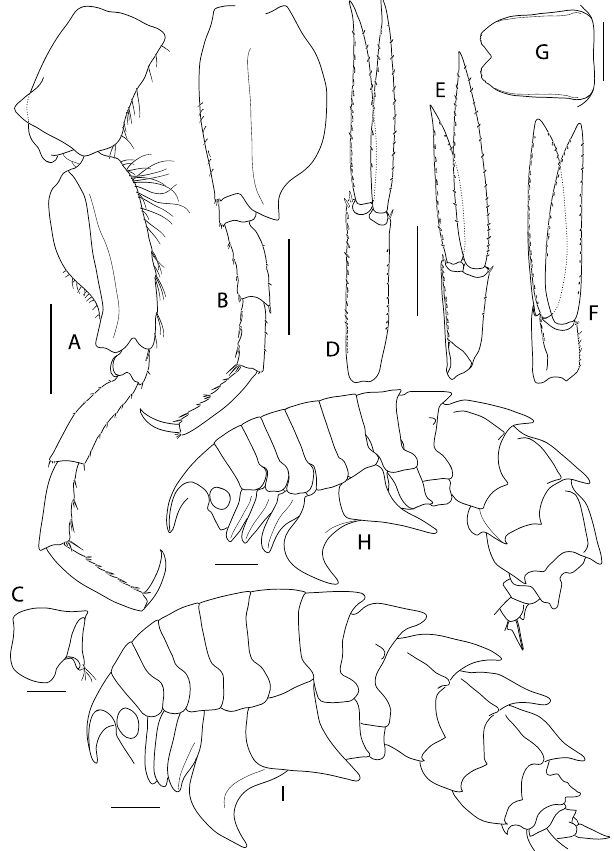
Head (Fig. 8C) about as high as long; ventral lobus slightly rounded, anterior corner rectangular. Rostrum weakly curved, ventral margin almost straight, about as long as 1 st peduncular article of antenna 1. Eyes large and rounded, bulging. Antenna 1 (Fig. 9A) peduncular article 1 about 1.4 as long as articles 2–3 combined (length ratio 1: 0.5: 0.3); accessory flagellum consisting of a single tapering article, about 1/3 the length of the 1 st flagellar article; 1 st flagel- lar article about as long as peduncular article 2, primary flagellum with 30 articles. Antenna 2 (Fig. 9B) slightly longer than antenna 1; peduncular article 1 shortest, article 2 partly overlapping articles 1 and 3; article 3 with distal cusp; article 4 slightly longer than article 5; flagellum with 38 articles. Labrum (“upper lip”; Fig. 9D) ventrally rounded. Hypopharynx (“lower lip”; Fig. 9C) with distally tapering lobes, densely coated with fields of setae on the medial margins. Mandible (Fig. 9E) with 8-dentate incisor; lacinia mobilis triform (Fig. 9F); molar protruding, slender; man- dibular palp (Fig. 9G) consisting of 3 articles, bearing long setae on the distal half of article 2 and the entire article 3 posteromarginally; setae length on palp article 3 increasing from proximal to distal. Maxilla 1 (Fig. 10A) inner plate sub-triangular, with 11 stout plumose setae along the medial margin; outer plate truncate, with 11 mediodistally serrated spines (Fig. 10B); palp 2-articulate, article 2 about 5 times longer than the 1 st article, curved inwards, distally serrate with 4 blunt spines and few subdistal setae (Fig. 10B). Maxilla 2 (Fig. 10C) inner lobe broader and shorter than outer lobe, with numerous setae along the medial margin; outer lobe with a row of slender spines which are mediodistally serrate along with few short slender setae. Maxilliped (Fig. 10D,E) inner plate about 2/3 the length of 1 st palp article, apical ridge with blunt spines and stout setae; outer plate reaching about midpoint of palp article 2, ovoid, apical margin with progressively stouter, slender spines mediodistally, mediodistal region produced to a saw-like ridge; palp 4-articulate, medial margin of article 2 setose, article 3 with stout setae mediodistally, article 4 curved, with serrate medial margin. Gnathopod 1 (Fig. 11A) coxa tapering distally and with broadly rounded apical tip, anterior margin nearly straight, posterior margin slightly concave and bearing a row of very fine setae; basis about as long as coxa, slightly